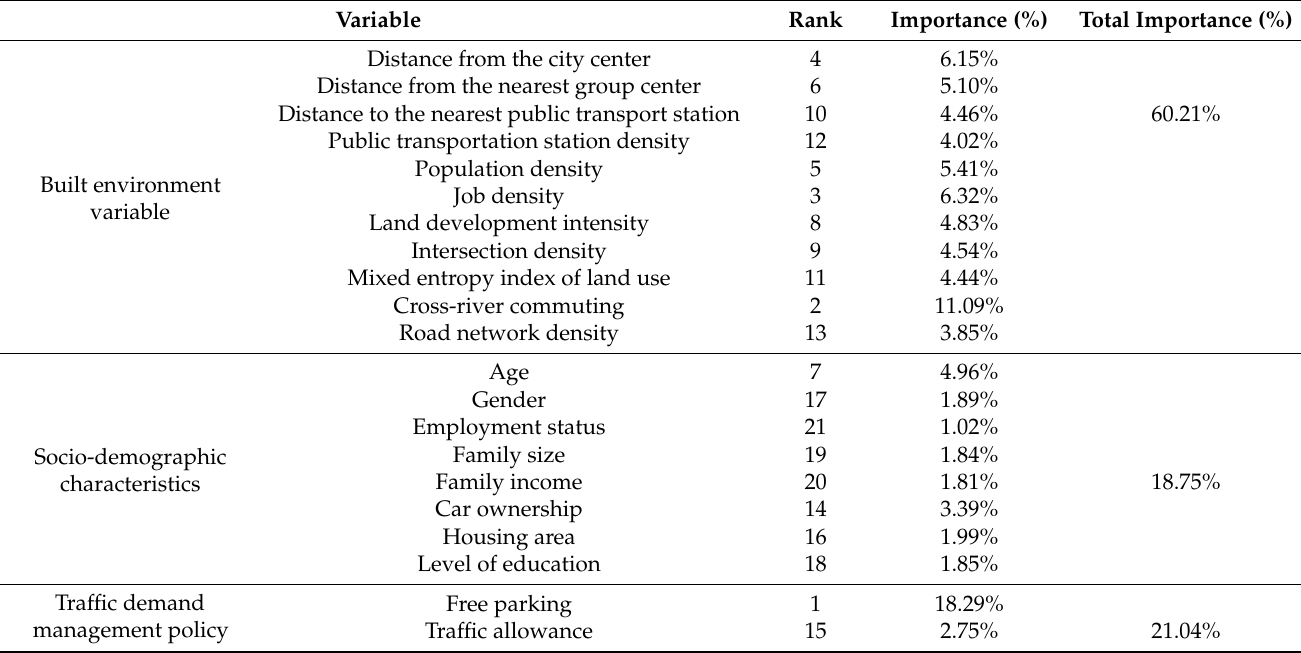
Table 4. Relative contribution of independent variables to commuting carbon